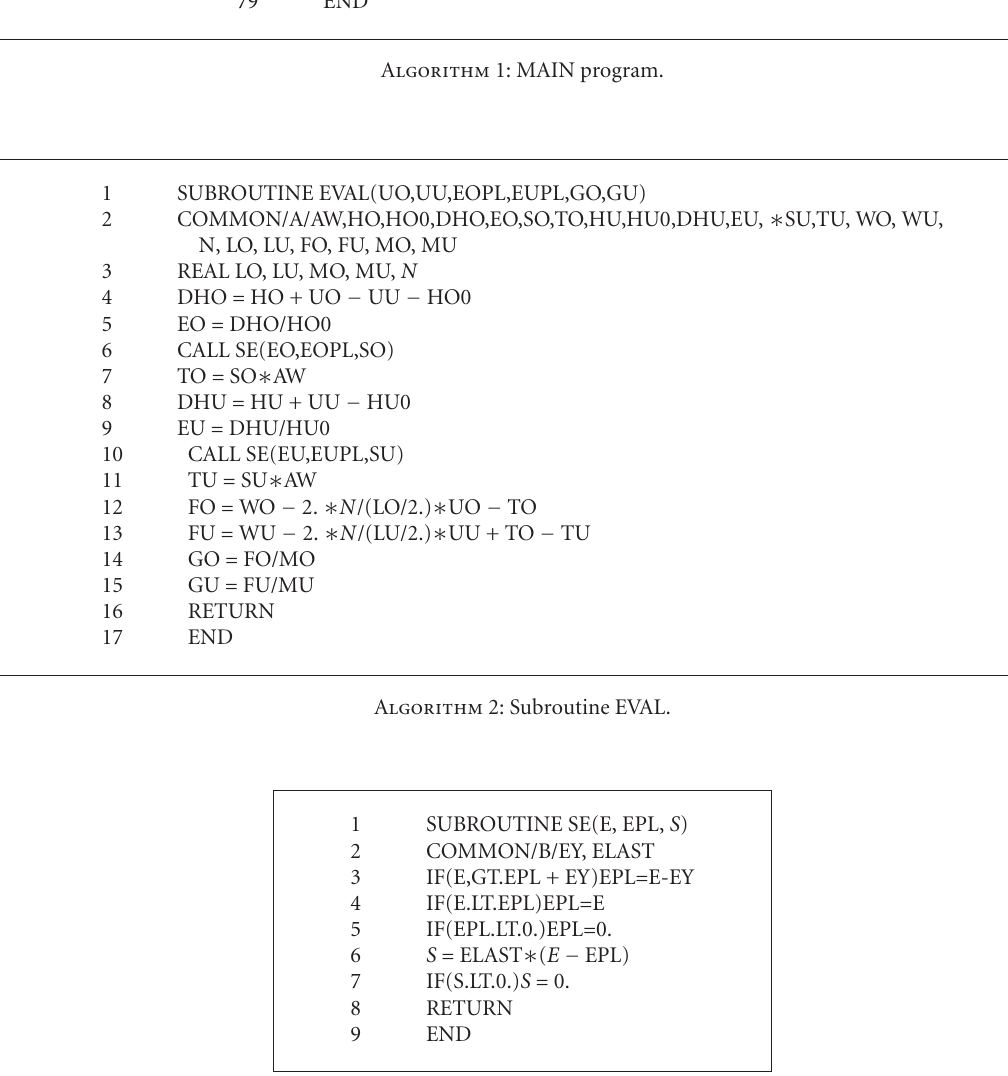
Algorithm 3: Subroutine